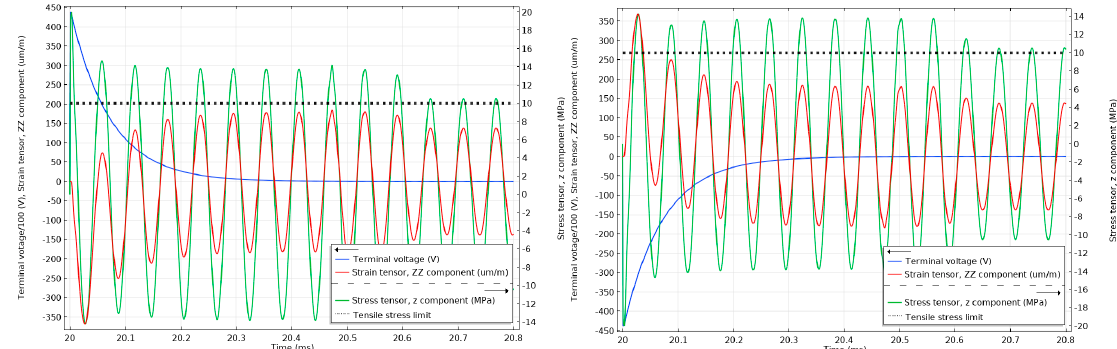
Figure 18. Stress and strain in the undamped stack when subjected to 1.2/50 µs 45 kV positive ( left ) and negative lightning impulses ( right ). The tensile stress limit of 10 MPa is marked by a black dotted line. (The terminal voltage is the voltage applied to the top electrode of the stack.).